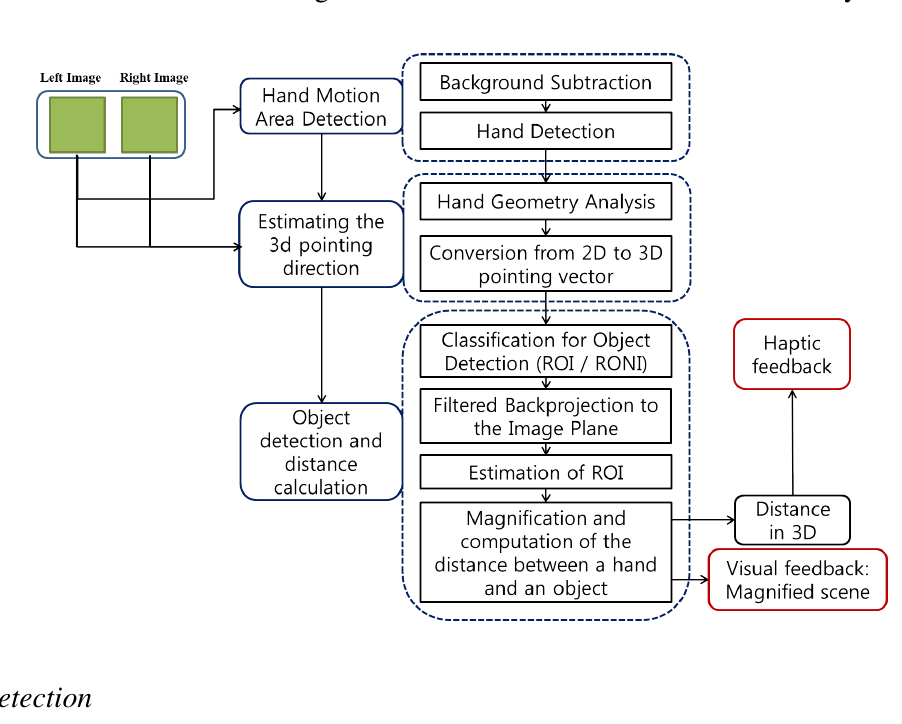
Figure 1. The flow chart of algorithms used in Visual Information Delivery